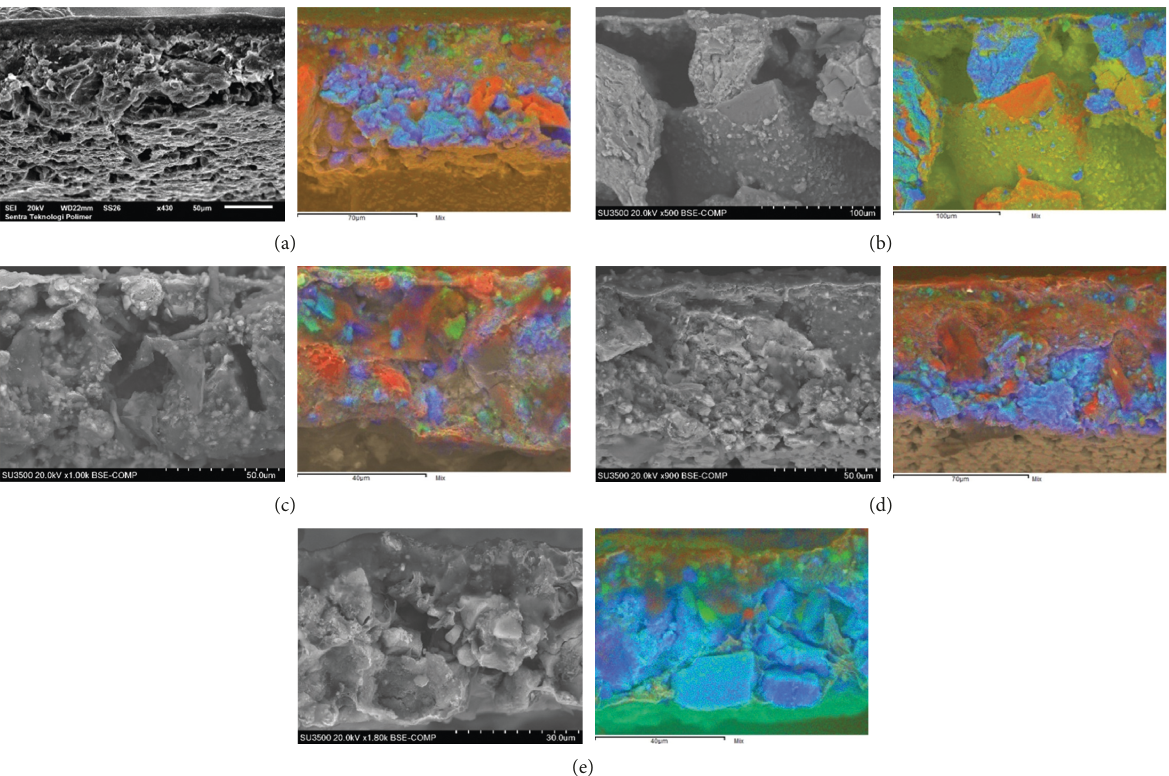
Figure 2: SEM-mapping micrograph of representative sample PVA/Zeo/AC. (a) 1:1:1; (b) 1:1:0.75; (c) 1 :1:0.5; (d) 1:1:0.25; (e) 1:1:0. C; O; Si. Table 3: Determining of q for each experiment. e